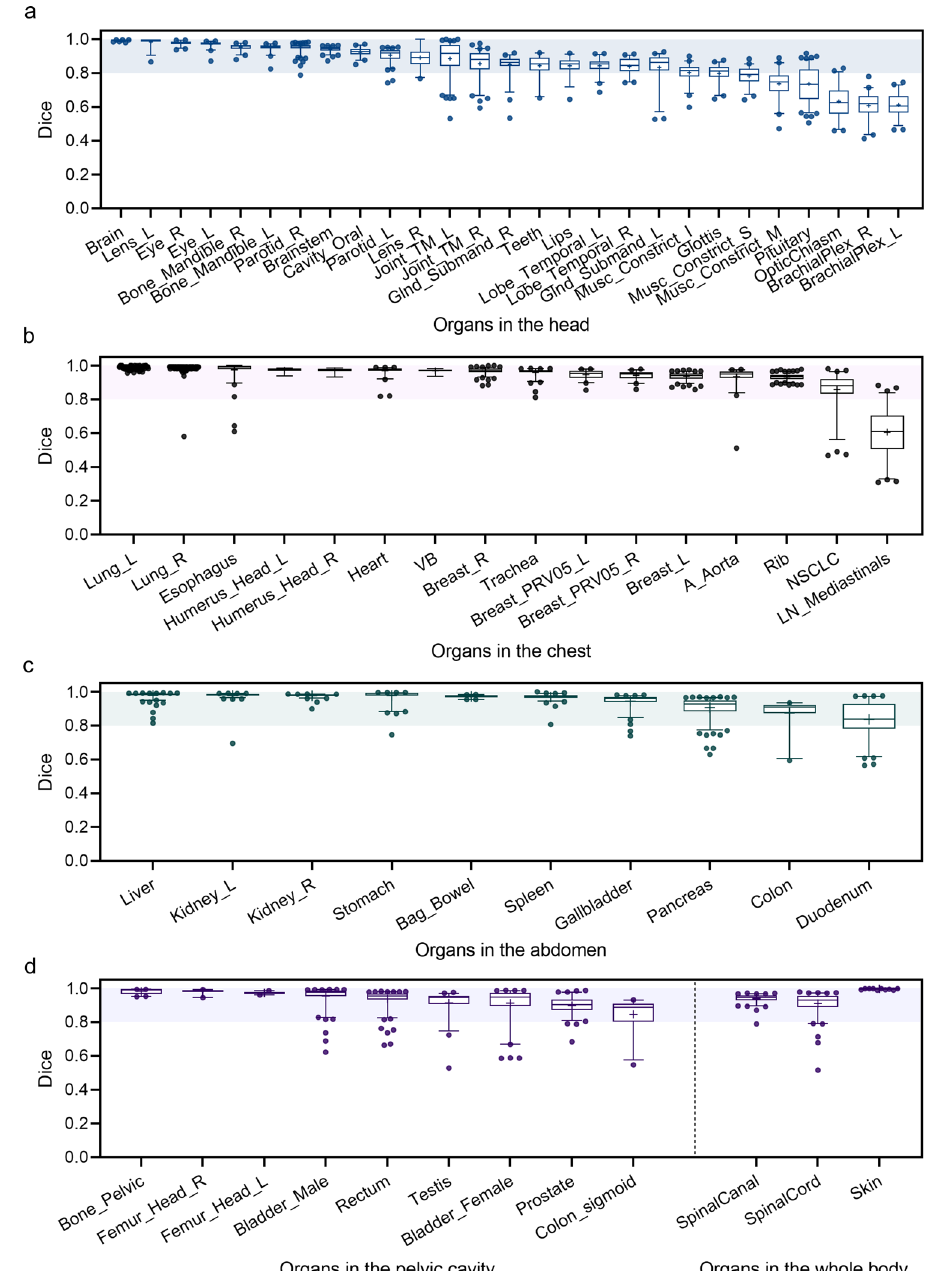
Fig. 3 | The segmentation performance of the RTP-Net on whole-body OARs. The Dice coef fi cients in segmenting OARs in the head ( a ), chest ( b ), abdomen ( c ) parts, aswell as those in the pelvic cavity partand whole body ( d ).The shadows in four box-and-whisker plots give the Dice coef fi cients with a range from 0.8 to 1.0. The fi rst quartileforms the bottomand the third quartile formsthe top ofthe box,